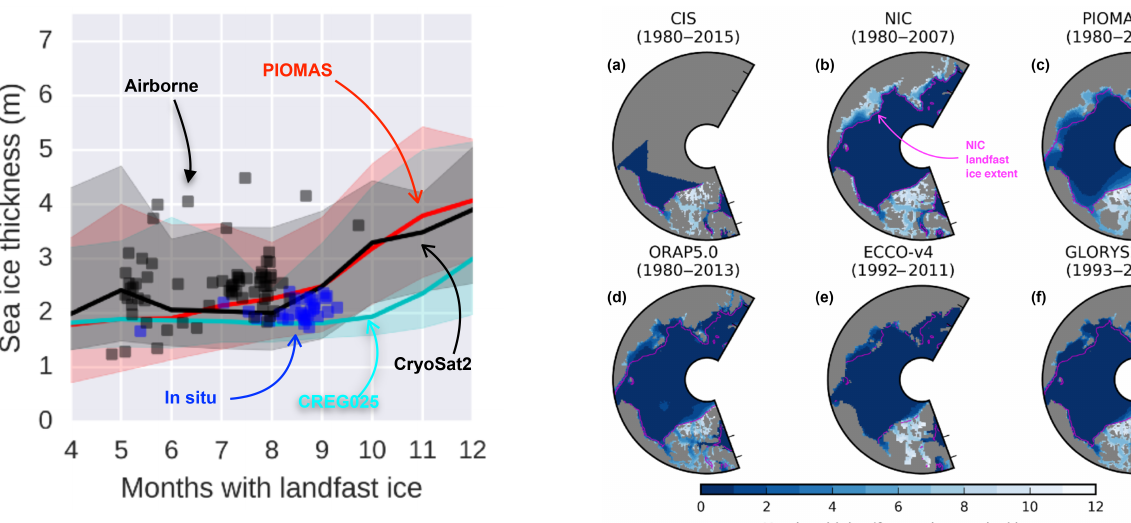
Figure 1. Canadian Arctic Archipelago (CAA) PIOMAS maximum ice thickness against landfast ice duration from Canadian Ice Ser- vice (CIS) ice charts over the 1980–2015 period (the mean is the thick red line, 95 one-sided percentile is the red shading). In black, the same is shown for CryoSat2 instead of PIOMAS over the period 2010–2015 (see Fig. S1 in the Supplement for coverage). In cyan, the same is shown for the operational model CREG025 instead of PIOMAS over the years 2004–2010. In black squares, the same is shown for airborne electromagnetic measurements in spring 2011 and 2015 over a small region of the CAA (see Fig. S2 for coverage). In blue squares, the same in shown for the in situ CIS Ice Monitor- ing programme at Cambridge Bay, Resolute Bay, Eureka and Alert over the period 1980–2015.